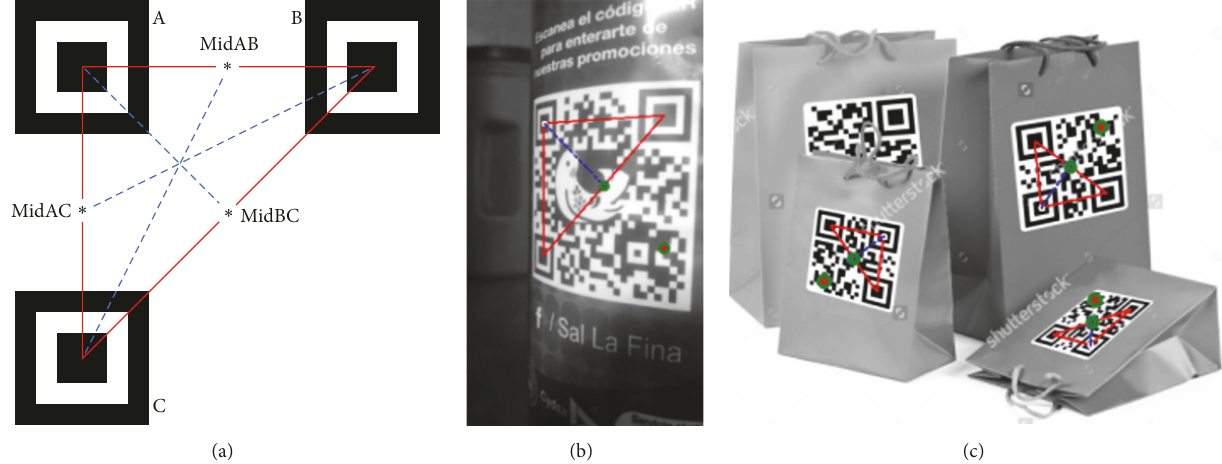
Figure 9: (a) Detection of rectangular triangle; (b) example of detected triangle; (c) detection of multiple QR codes with corresponding triangles connecting three PDPs.